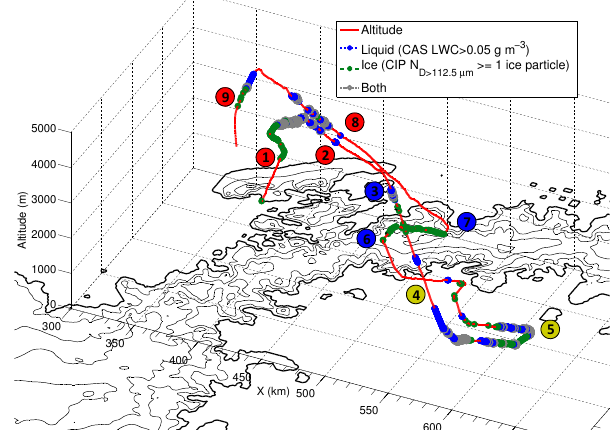
Fig. 4. 3-D isometric view of flight #104 looking approximately from the east over the Antarctic Peninsula. The contours represent 500m terrain height steps; blue symbols without numbers (see the legend) show regions where liquid water was detected with CAS LWC values > 0.05gm − 3 ; green symbols show regions where at least one ice particle with D > 112 . 5µm was detected by the CIP per second; and grey symbols represent mixed phase regions (i.e. both the above criteria met). The coloured symbols with numbers inside indicate the approximate positions of the markers in Figs. 2 and